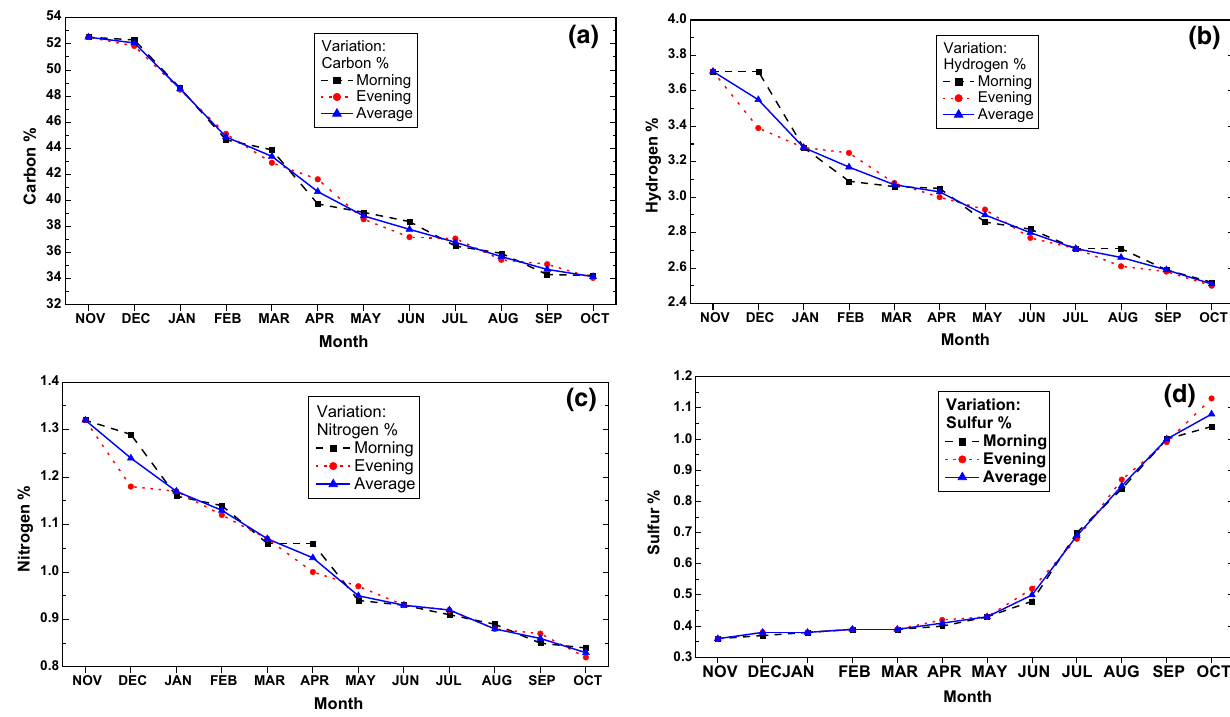
Fig. 1 Variation of a carbon, b hydrogen, c nitrogen, d sulfur due to weathering (on dry